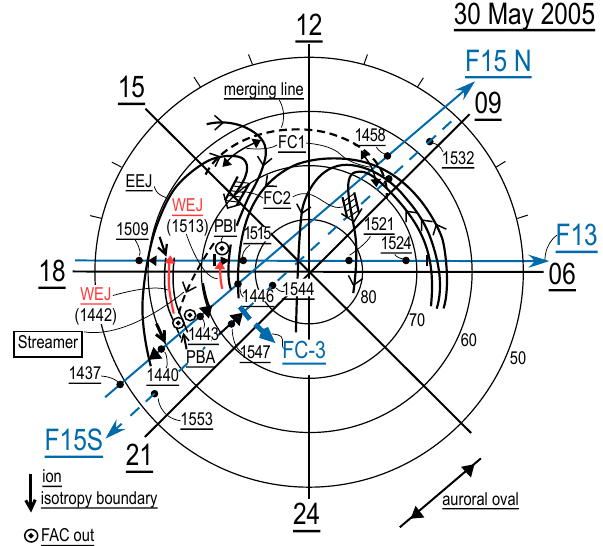
Fig. 2. Illustration of observation geometry on 30 May 2005 with schematic convection pattern and flow channels along the polar cap boundary superimposed. Three satellite passes occurring dur- ing different phases of substorm evolution are marked: (i) DMSP F15 (pre-midnight to pre-noon) and DMSP F13 (dusk to dawn) during the intervals 14:37–14:58 and 15:09–15:24UT, respectively, in the Northern Hemisphere and (ii) one F15 pass in the south (blue dashed line) from pre-noon to pre-midnight during the inter- val 15:32–15:53UT. Approximate convection pattern (streamlines) and merging line (dashed curved line) are shown as well as east- ward (EEJ) and westward (WEJ; 14:42 and 15:13UT; red arrows) electrojets and precipitation features at dusk/pre-midnight (isotropy boundary, pre-breakup arc (PBA; 14:43UT), poleward boundary in- tensification (PBI; 15:13UT) observed along the satellite tracks in the north and south (see text for details). FC 3 marks a nightside flow channel ( V i > 2kms − 1 ) at the the polar cap boundary in the south traversed by spacecraft F15 just before 15:47UT (see data below). Flow channels along the polar cap boundary on the dayside are marked FC 1 (newly open field lines) and FC 2 (old open field lines). The coordinate system is MLAT versus